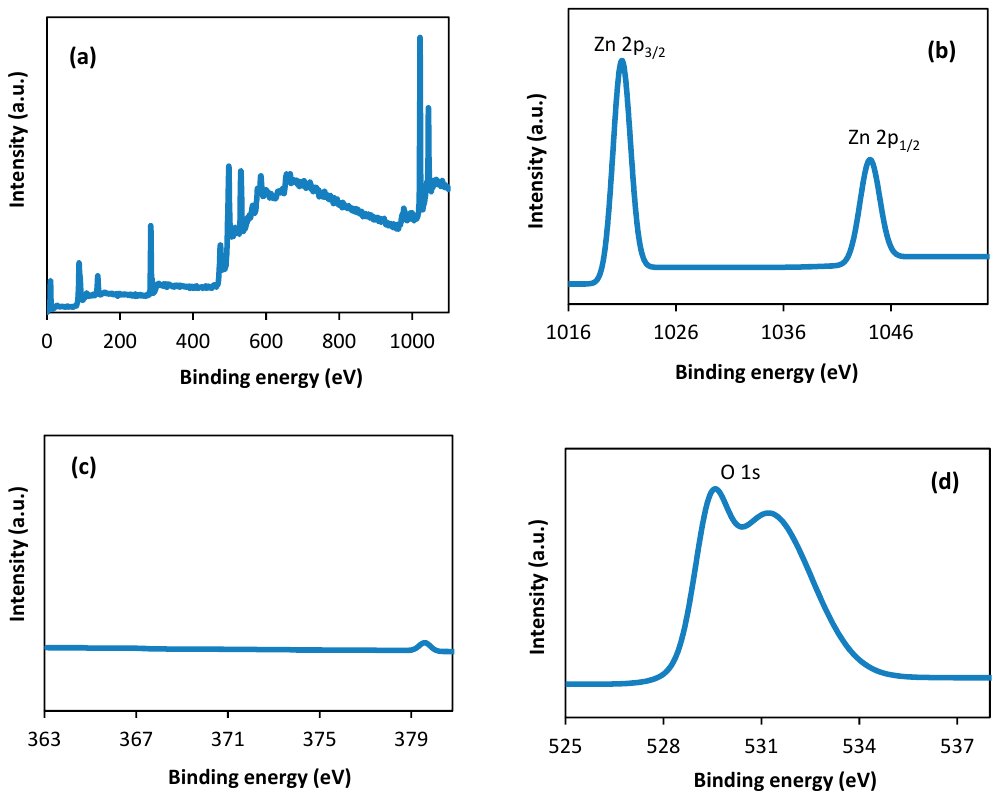
Figure 10. ( a ) Full range X-ray photoelectron spectroscopy (XPS) spectra of ZnO; ( b – d ) High resolution XPS spectra of Zn 2P, Ag 3d and O 1s for ZnO.